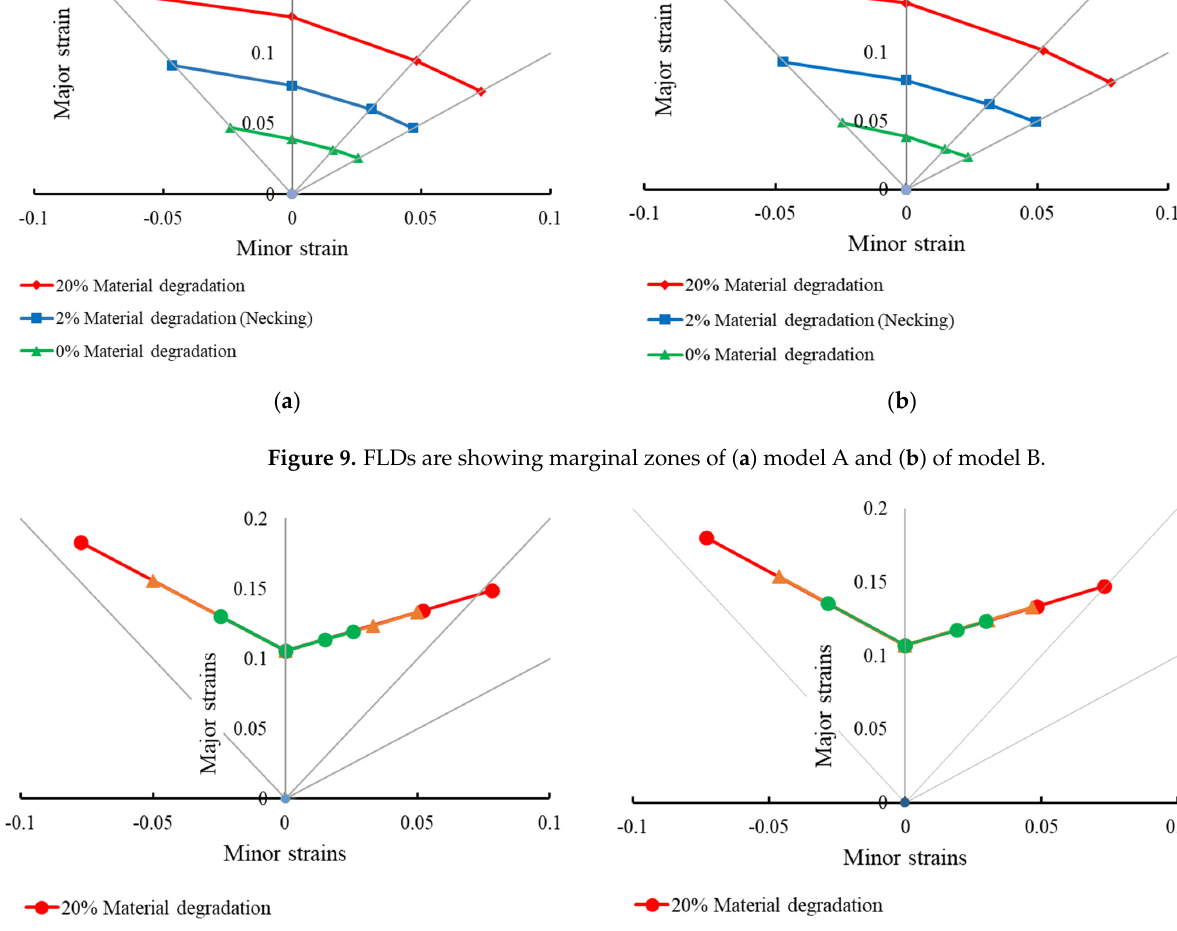
Figure 10. The FLDs marginal zones for ( a ) martensite grain sizes = 2.7 µm and for ( b ) martensite grain sizes = 6 µm.